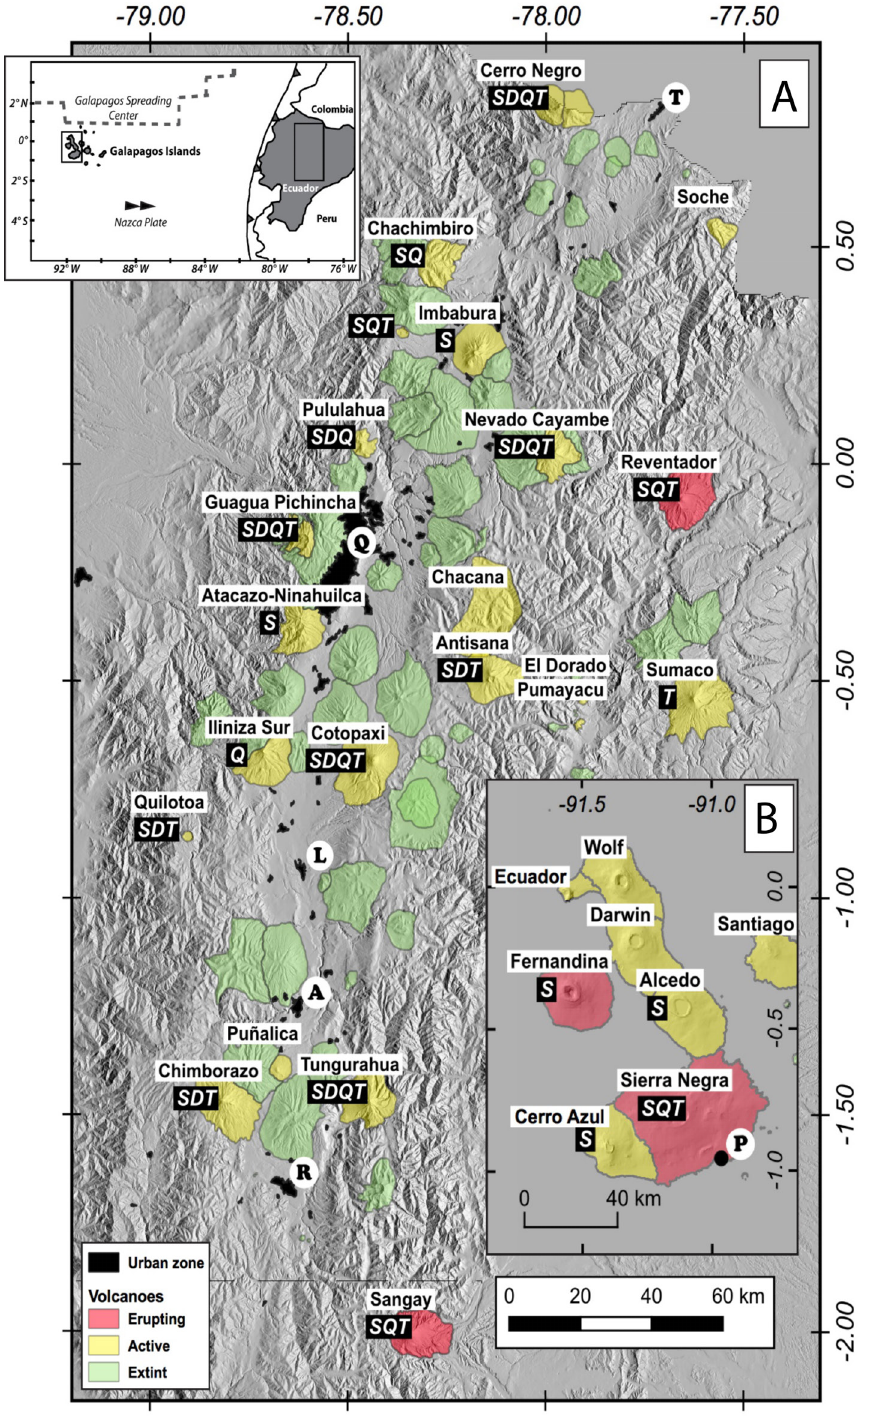
Figure 1: Ecuadorian volcanoes distributed in [A] mainland, and [B] the Galápagos Islands. Dormant or extinct volcanoes are shown in green, active volcanoes in yellow and erupting volcanoes (currently erupting or had an eruption within the last two years, i.e. 2018–2020) in red. The names of the volcanoes are written in black inside white boxes. Black bold letters in white circles represent the main cities, from north to south: T: Tulcán, Q: Quito, L: Latacunga, A: Ambato, R: Riobamba, P: Puerto Villamil. White letters in black boxes represent the different types of monitoring carried out on the volcanoes: S: Seismic (seismic and/or infrasound), D: Geodetic (GPS and/or tiltmeter), Q: Geochemistry (gas, fluids), T: Thermal/visual (airborne and/or ground-based thermal